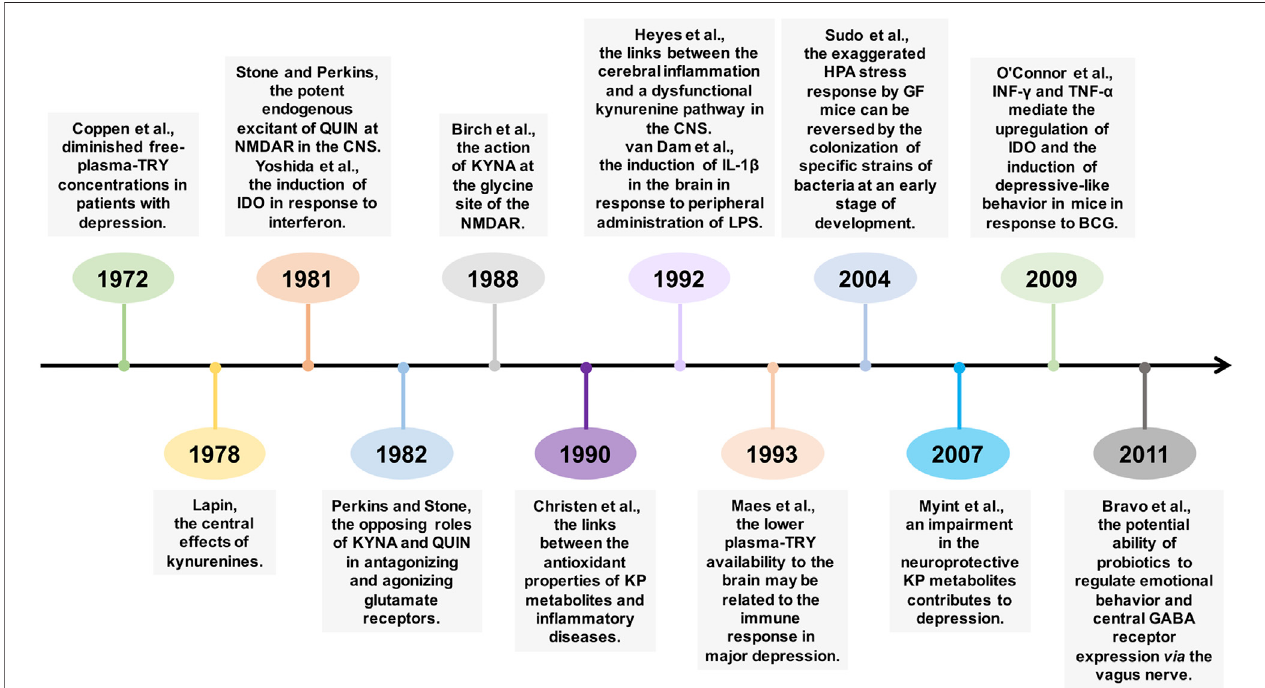
FIGURE 2 | The timeline of key, seminal original discoveries that gave rise to the fi elds of research on the kynurenine pathway (KP) in mood disorders and the gut- brain axis. Note. TRY: tryptophan, QUIN: quinolinic acid, NMDAR: N-methyl- D -aspartate receptor, CNS: central nervous system, IDO: indoleamine 2,3-dioxygenase, KYNA: kynurenic acid, IL-1 β : interleukin-1 β , LPS: lipopolysaccharide, HPA: hypothalamic-pituitary-adrenal, GF: germ-free, GABA: gamma-aminobutyric acid, TNF- α : tumor necrosis factor- α , BCG: bacille Calmette-Guérin.